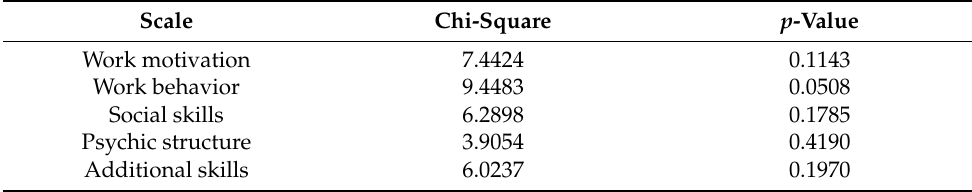
Table 9. Kruskal–Wallis test statistics when the sample is differentiated by age